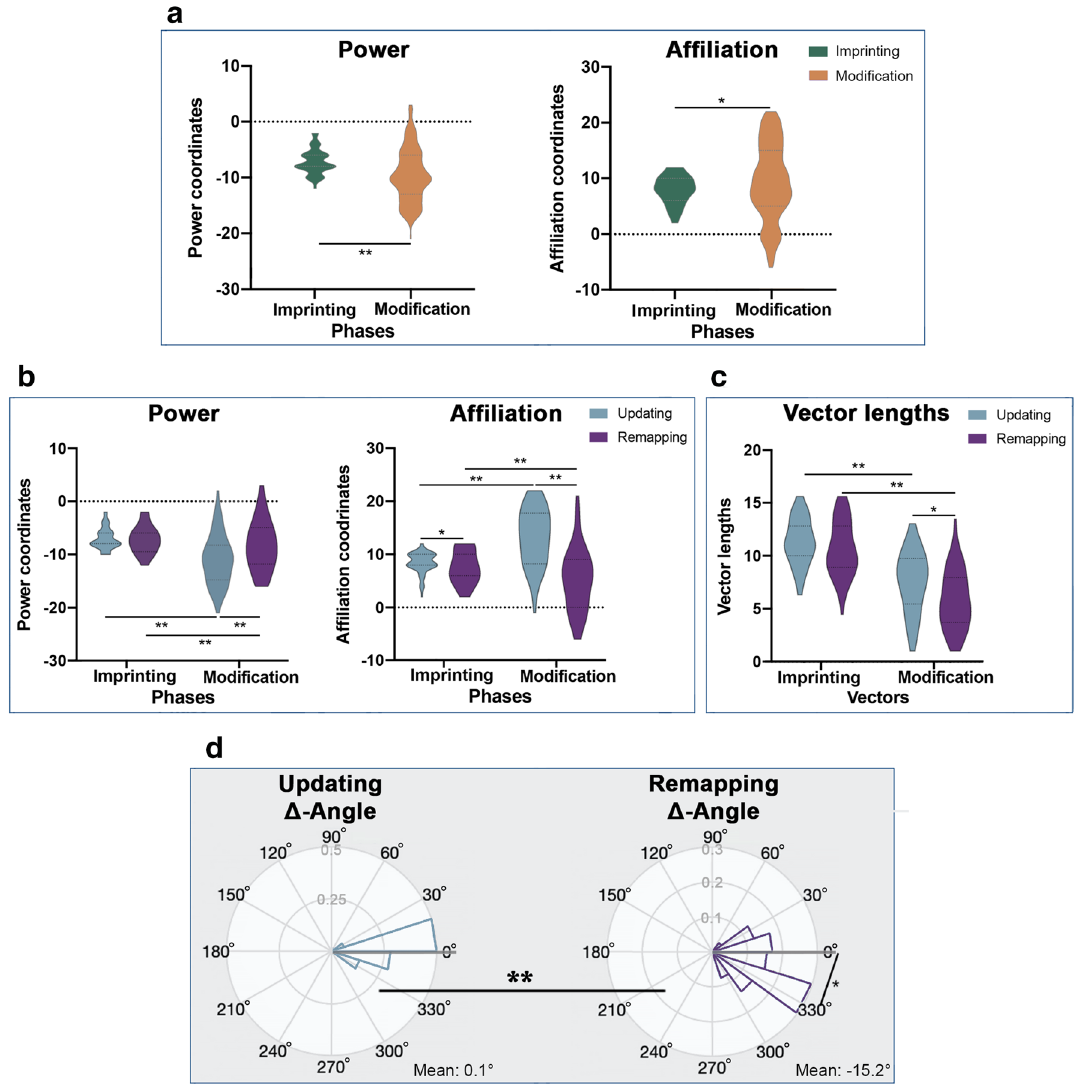
Figure 2. Updating and remapping of ‘social space’ across the group of younger and older adults. ( a ) Main effect of phase in power- and affiliation-coordinates: After modification-phase, avatars had significantly higher absolute power- and higher absolute affiliation-coordinates than after imprinting-phase. Note that the analysis is based on normalized data. ( b ) Interaction between condition and phase in power- and affiliation-coordinates: After the modification-phase, updating-avatars had significantly higher absolute power-coordinates. Affiliation- coordinates were higher for the updating avatars at the imprinting-phase and at the modification-phase, whereas the effect was stronger during the modification-phase. Note that the analysis is based on normalized data. ( c ) Interaction effect of condition and phase in vector lengths: Remapping-avatars show significantly shorter modification-vectors than updating-avatars. ( d ) Difference between conditions: The difference between Δ-angles of conditions was significant. Also, only remapping-avatars’ Δ-angles show a significant difference from 0° (bold grey